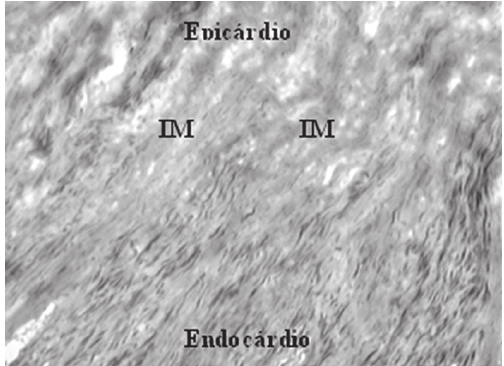
Fig. 2 - Infarto do miocárdio (IM) - Tricrômio de Gomery, x400